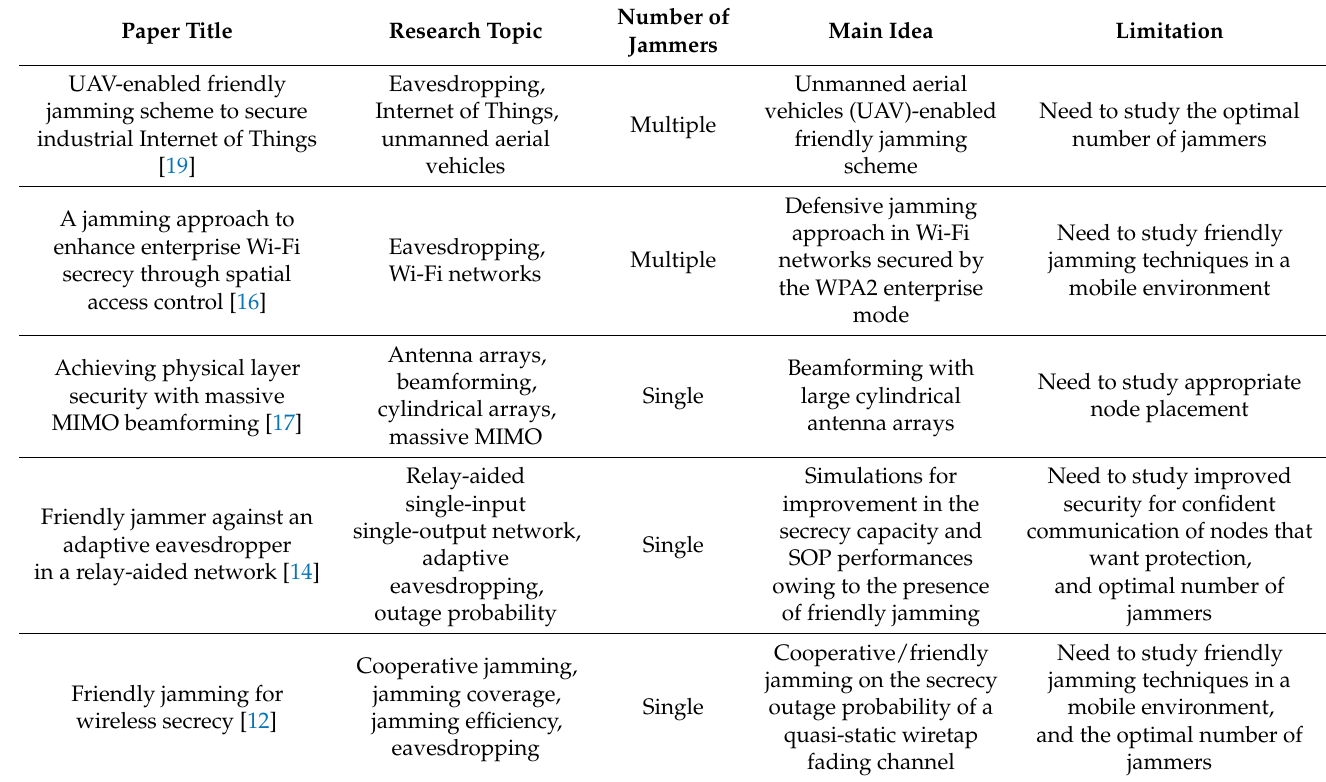
Table 1. Comparison of prior studies on friendly